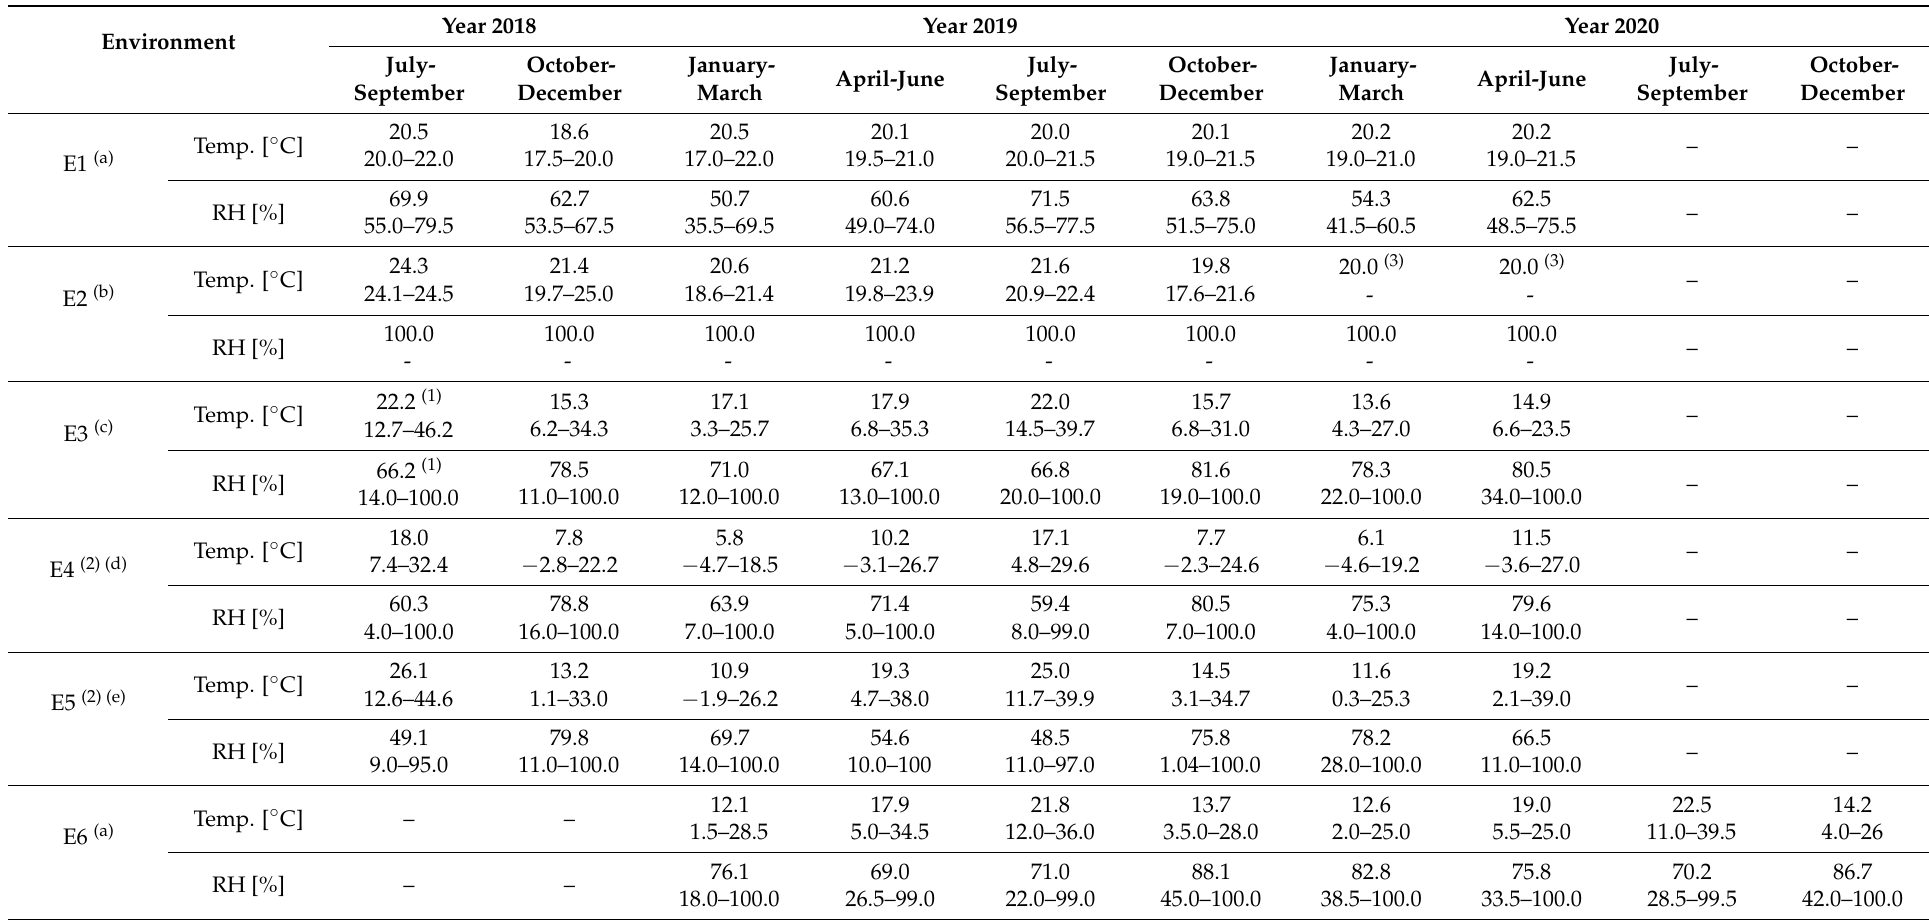
Table 3. Values of the temperature and relative humidity registered between the years 2018 and 2020 for the different environments studied.